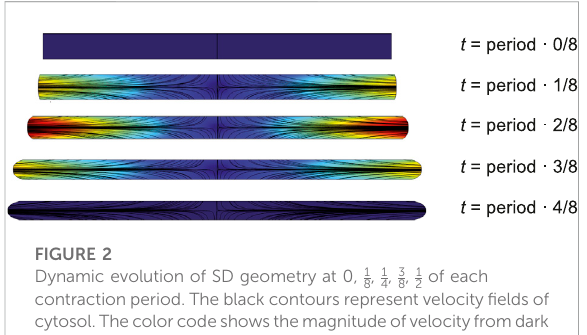
, 1 , 3 , 1 of each 8 4 8 2